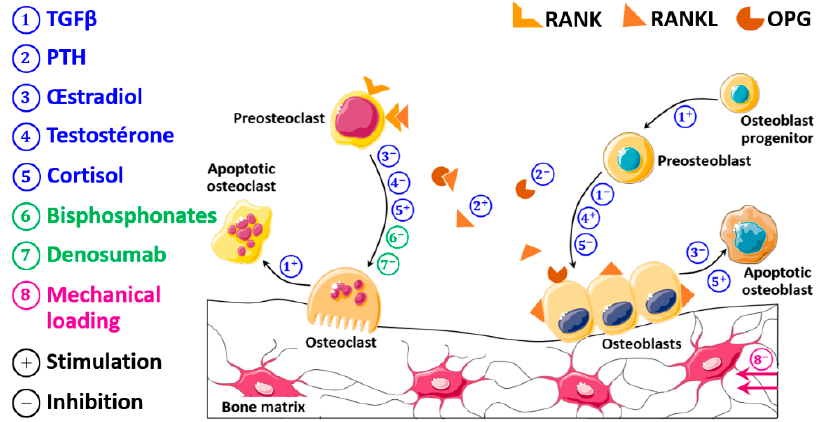
Figure 3. Summary of the proposed bone remodeling model. The shown numbers indicate the involved parameter; the positive and negative signs indicate stimulation or inhibition, respectively, exerted by each factor; the blue color indicates the biological parameters of the model, the green the pharmacological parameters and the purple the mechanical loading.